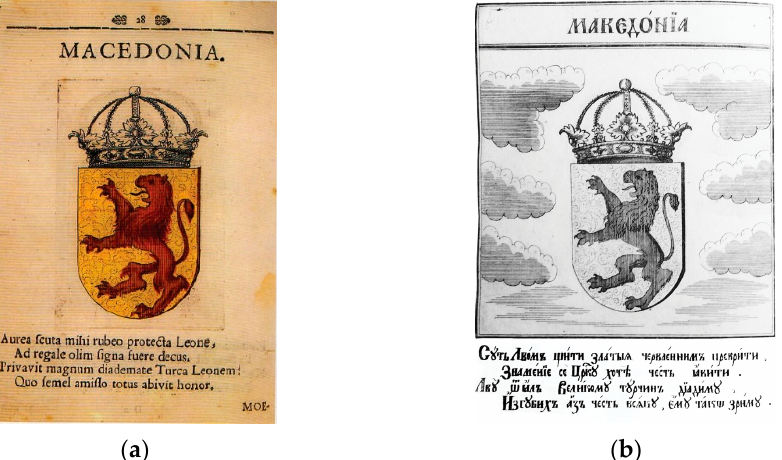
Figure 11. ( a ) Macedonian coat of arms (Vitezovic Stemmatographia); ( b ) Zhefarovic Stem-